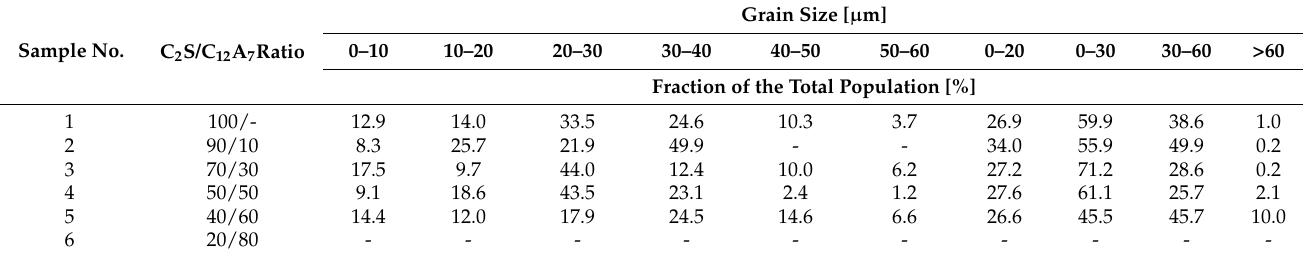
Table 7. Particle size distribution depending on the C 2 S/C 12 A 7 ratio in the investigated samples.